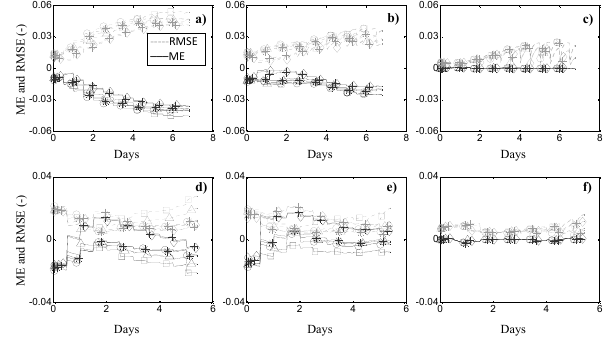
Figure 12. Evolving mean errors (MEs) and root mean square er- rors (RMSEs) between predicted and measured profiles using GA3 (a–c) and GB1 (d–f) experimental data series, with assimilation fre- quency AF = 1/12h − 1 , and observation depths: (a, d) OD = 1cm, (b, e) OD = 2cm, and (c, f) OD = 12cm. The analysis accounts for the six pondered sets of initial parameters S1( (cid:13) ) , S2 ( (cid:3) ) , S3 ( ∗ ) , S4 ( 1) , S5 ( + ) and S6 ( ♦ )